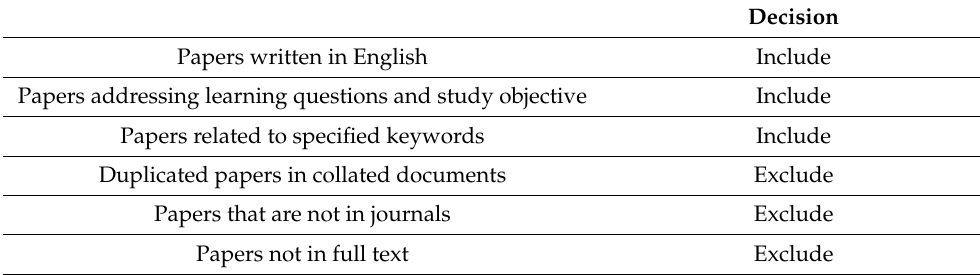
Table 2. Inclusion and exclusion of studies based on criteria.